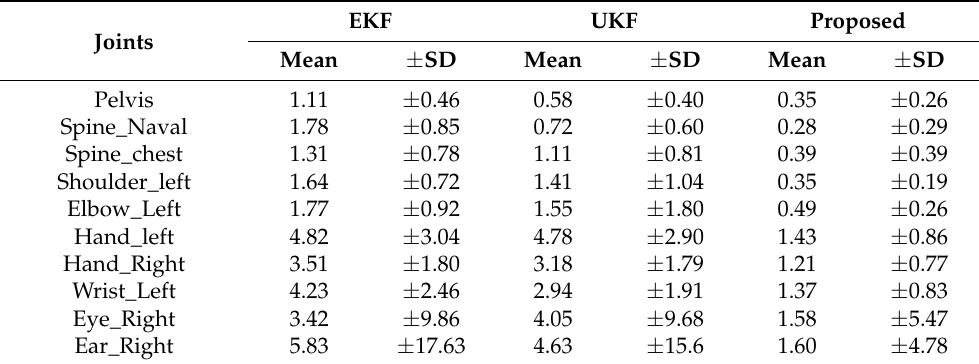
Table 1. Results of RMSE_mean and RMSE_( ± SD) of skeleton joints for each method.